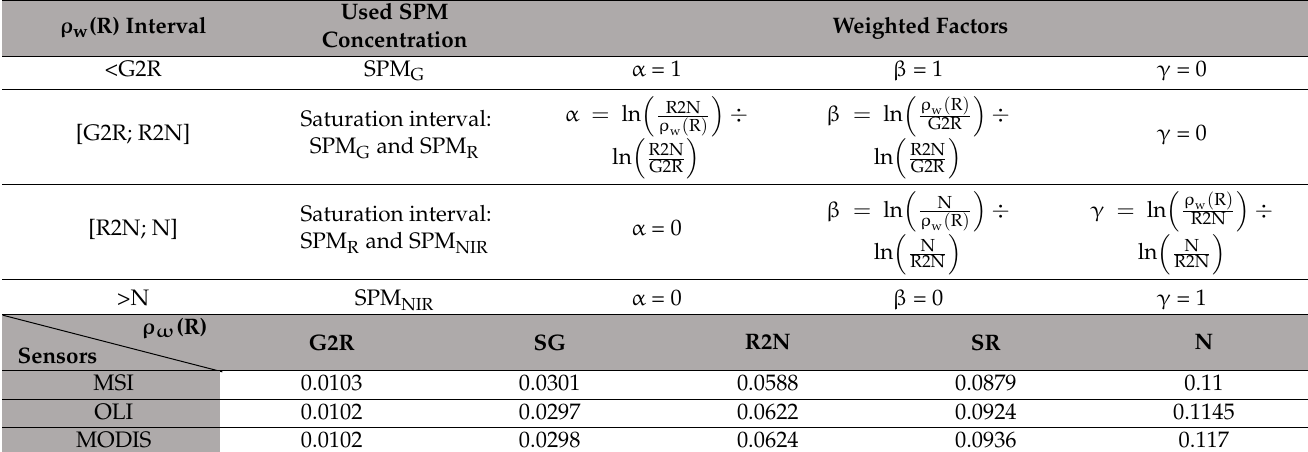
Table 3. Saturation intervals and weighting factors ( α , β , and γ ) used to compute the SPM SA concentration using the switching algorithm. Saturation interval radiometric bounds values are indicated for each sensor (the green (S G ) and red (S R ) saturation point values are indicated but not used in the algorithm and the R radiometric bound is not used in the algorithm, see Appendix